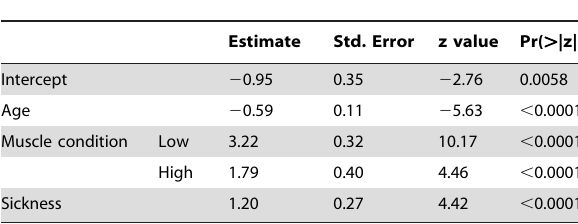
Table 4. Estimates of the factors affecting predation from the best ranked model, which included age as a continuous covariate, muscle condition as a factor with three levels (normal, low and high), and sickness, as a factor with two levels (healthy and sick).